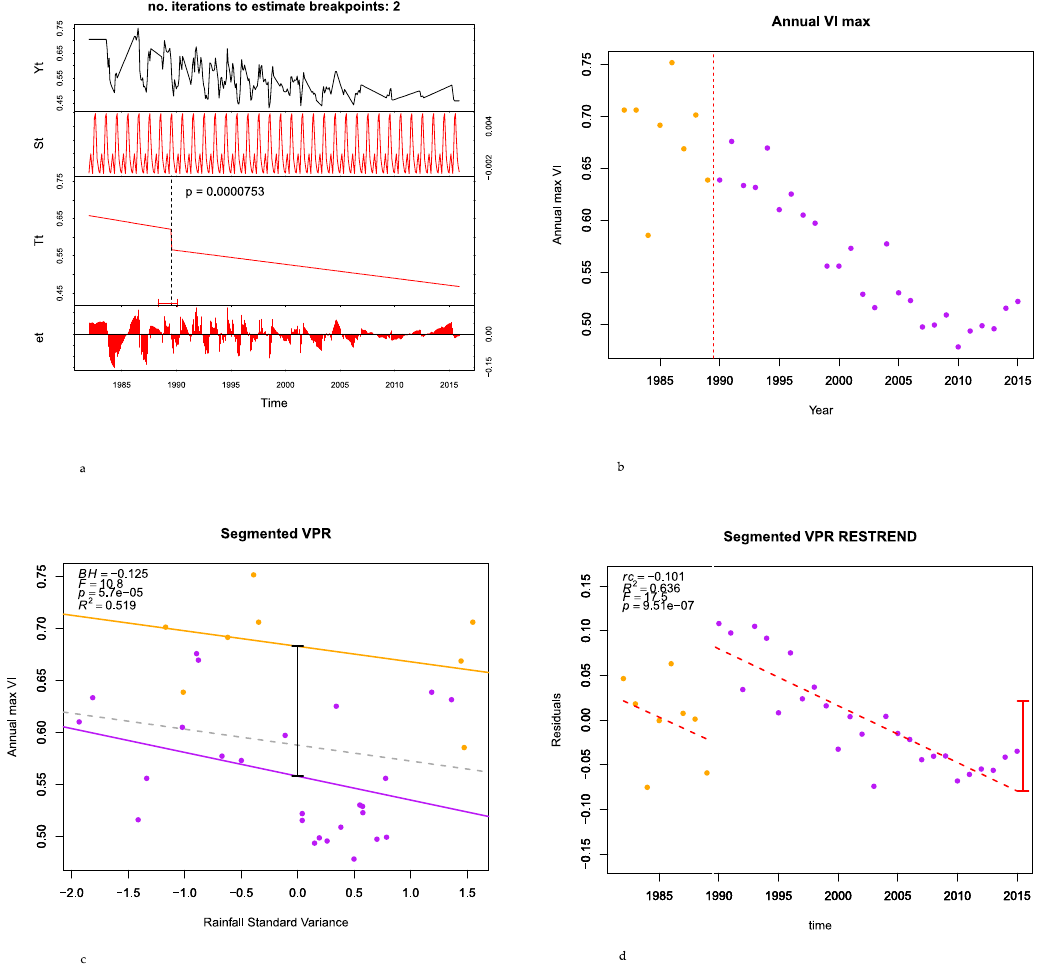
Figure 2. ( a – c ) The output of the Time Series Segmented Residual Trends (TSS-RESTREND) analysis across the Zambezi Region. ( a ) The overall vegetation trajectory is derived from the regression of the residuals of the complete time series (CTS residuals) using Breaks For Additive Seasonal and Trend (BFAST). Here, Yt = CTS residual time series, st = seasonal component (switched off during the analysis), Tt = trend component, and et = residual component. ( b ) The reordered temporal distribution of normalized difference vegetation index (NDVI max ) over time. The vertical dotted line represents the position of the breakpoint. The orange and purple points are the values before and after the breakpoint, respectively. ( c ) The standardized change in the segmented vegetation precipitation relationship (VPR) are before (orange) and after (purple) the detected breakpoint. The break height of the VPR (BH = − 0.125) is indicated by the black bar; the broken gray line is the VPR fitted to the data using a standard RESTREND. ( d ) The segmented RESTREND method that was used with the segmented VPR. The residual change (rc = − 0.101) is indicated by the red vertical bar. To calculate the total change (TC = − 0.226), we added the BH and the rc. The p -value and R 2 are also displayed on the graph.